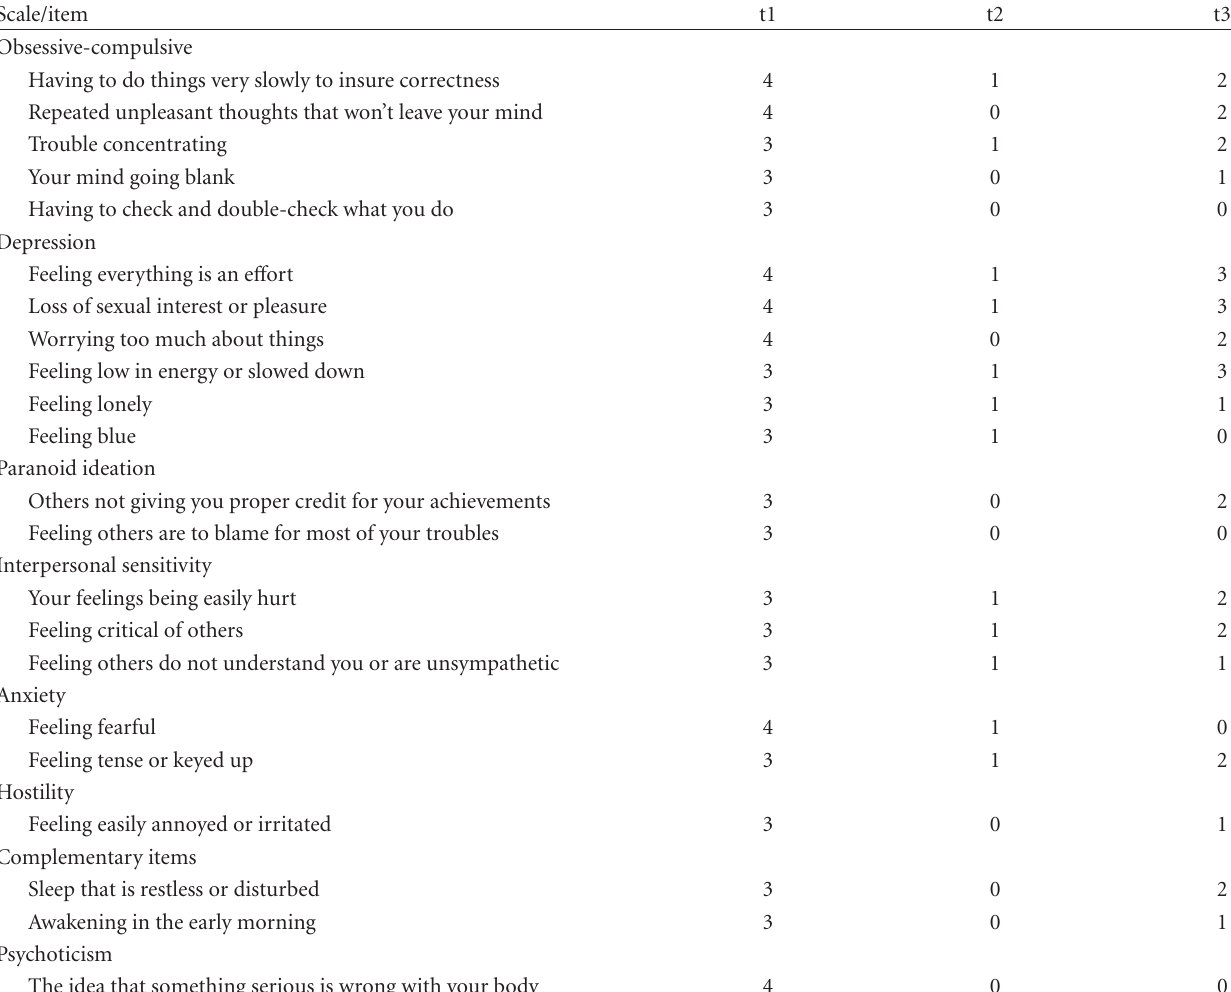
Table 1: Severe symptom items (value 3 or 4 at any time point) of the SCL-90 R. Seventeen items the patient highly complained of at t1 (value 3 or 4) are presented. (t1: beginning of inpatient therapy. t2: end of inpatient therapy. t3: follow-up. The items are organized by corresponding scales. The scales are sorted by their value at the